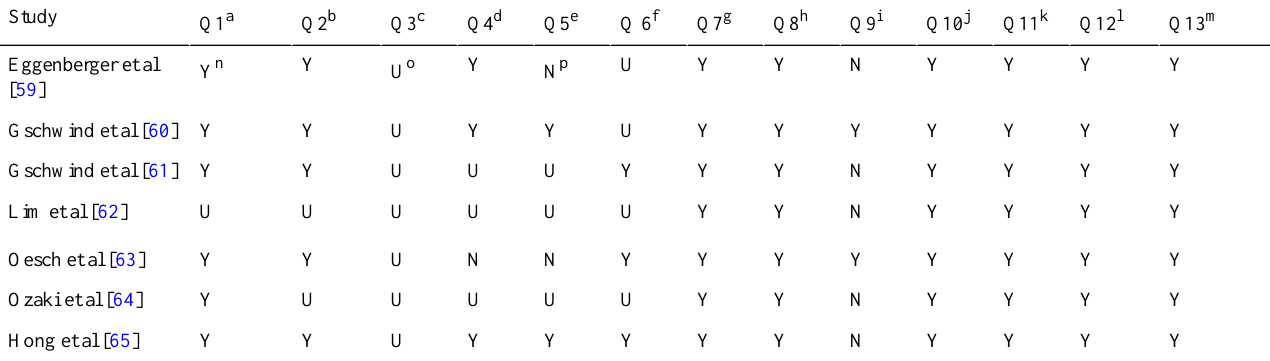
Table 2. Methodological quality of randomized controlled trials based on the Joanna Briggs Institute Critical Appraisal Checklist.